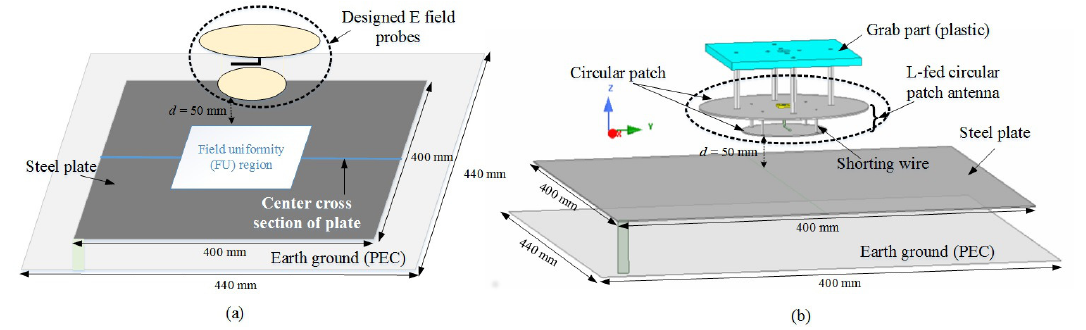
Figure 5. Simulation setup for NFIT method: ( a ) Schematic design; and ( b ) HFSS simulation setup with designed E-field probes.